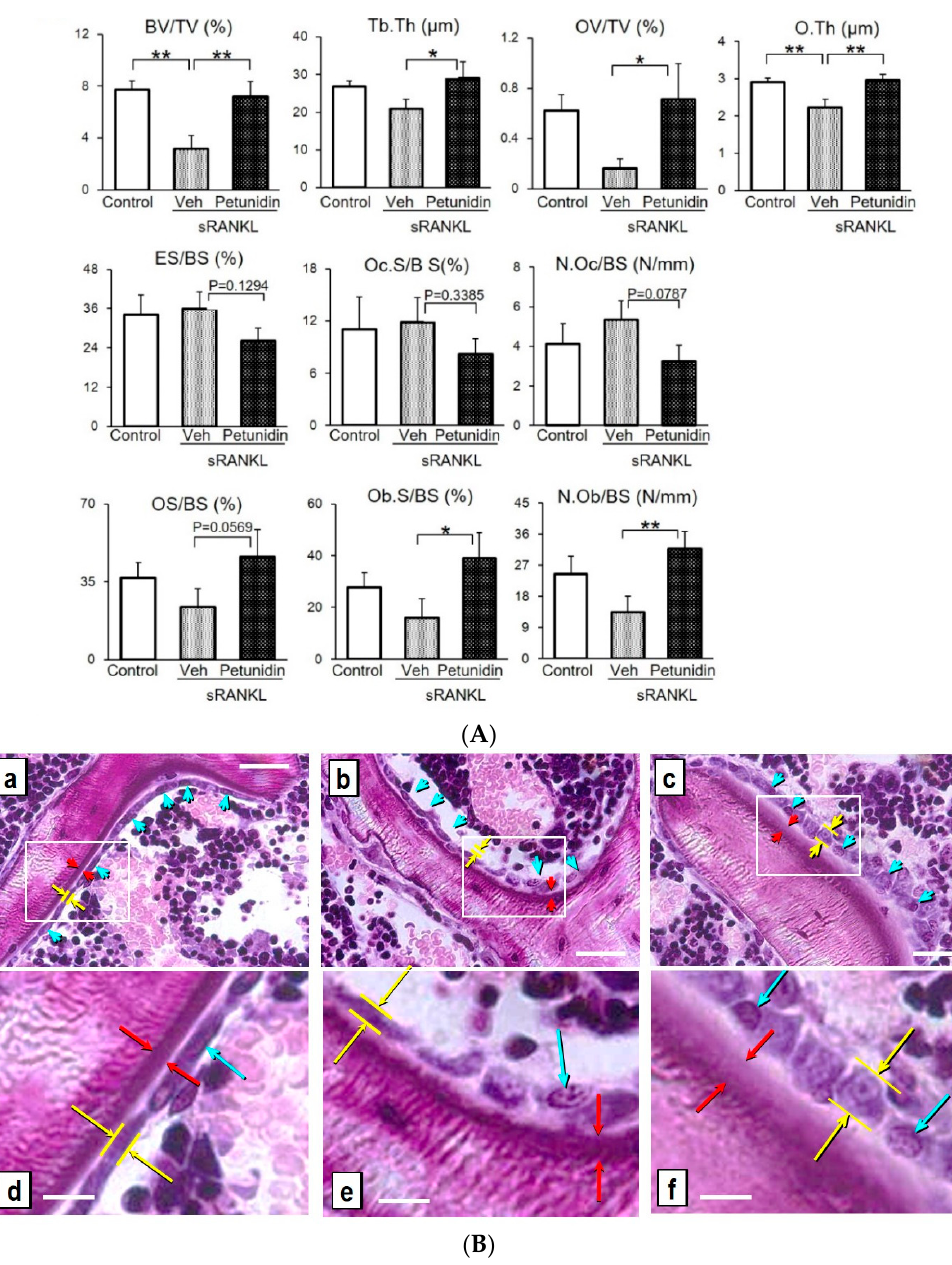
Figure 8. Histomorphometric analyses of protective effect of petunidin against bone loss in sRANKL-induced osteopenia mice. ( A ) Parameters were determined by morphometric analyses of second trabecular spongiosa of the distal femurs according to the methods of the ASBMR Histomorphometry Nomenclature Committee [31]. Values are expressed as the mean ± SD ( n = 5). * p < 0.05, ** p < 0.01. ( B ) Representative histological frontal sections stained by Villanueva staining of distal femurs in intact mouse (Figure 8Ba,d; control), sRANKL-induced osteopenia mouse (Figure 8Bb,e; vehicle), and petunidin 7.5 (mg / kg / day)-treated sRANKL-induced osteopenia mouse (Figure 8Bc,f). Figures in the lower panel (d–f) correspond to the squares in the upper panel (a–c). Blue arrows represent the osteoblasts. Distance between two yellow arrows and that of red arrows represent height of osteoblast and osteoid thickness, respectively. Scale bars = 30 µ m (Figure 8Ba–c), 10 µ m ((Figure